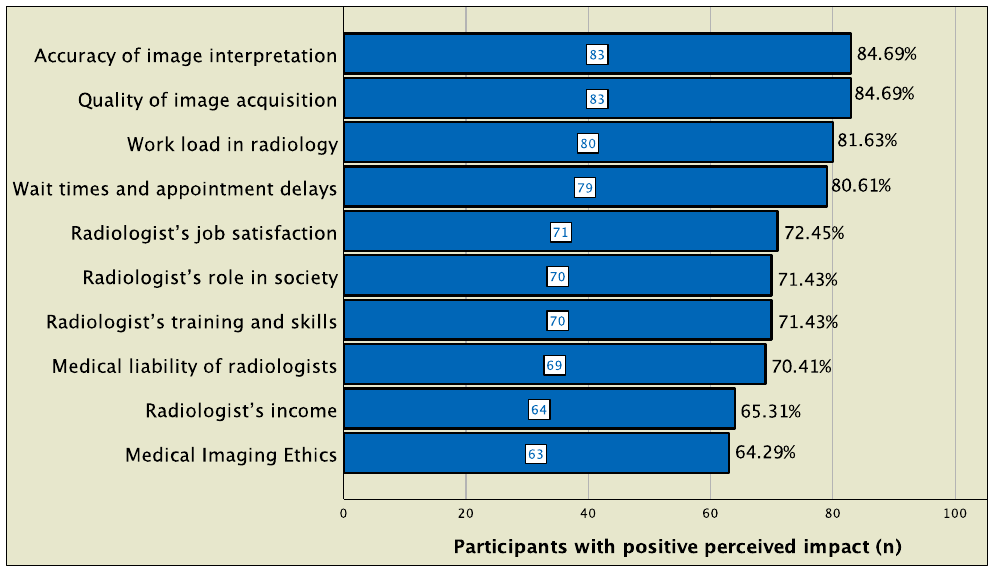
Figure 3. Attitudes regarding AI impact on the radiology profession. Bars represent the number of participants who perceived the impact of AI as being positive or very positive on the given aspect of the radiology profession.